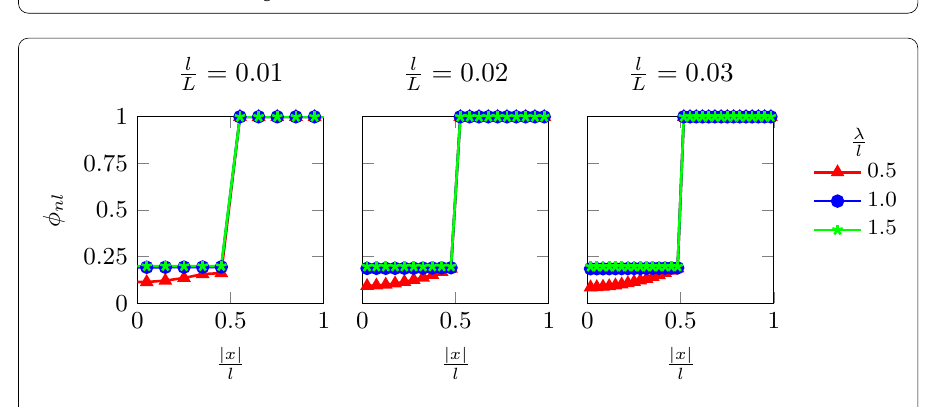
Fig. 6 Nonlocal damage φ nl distribution at (cid:3) ε (cid:4) E σ thicknesses and nonlocal length scales